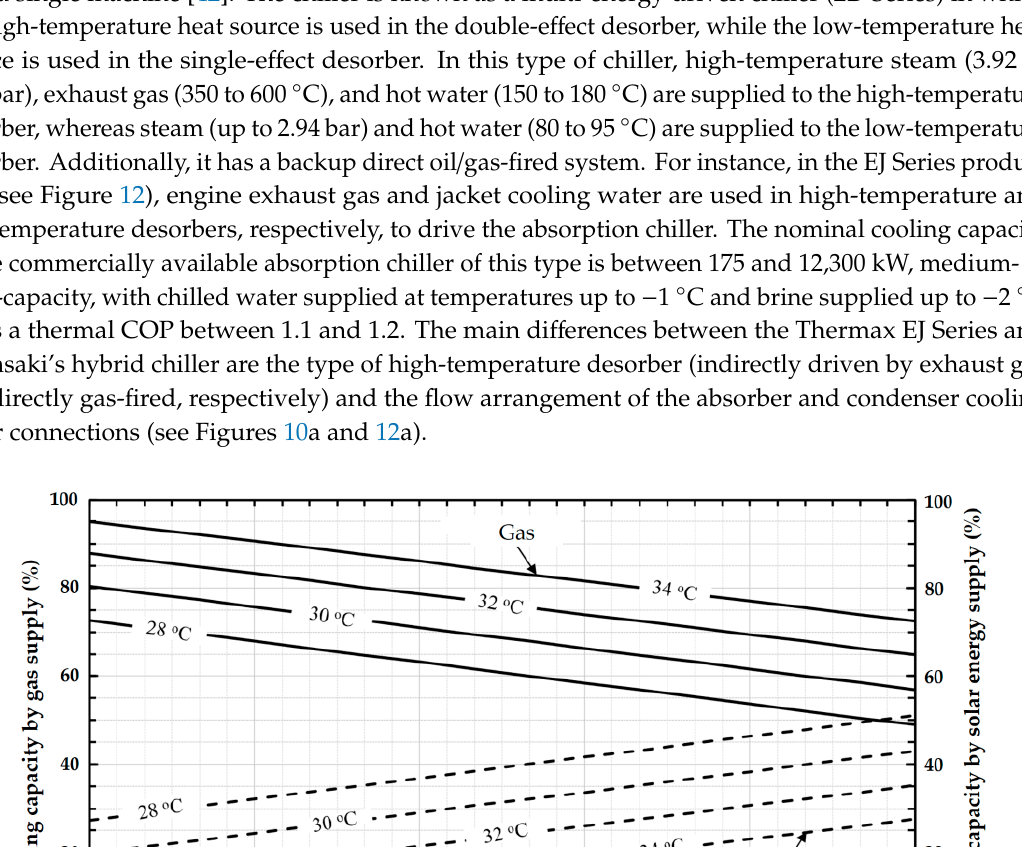
Figure 10. Solar ‐ gas ‐ fired single/double ‐ effect absorption chiller from Kawasaki Thermal Engineering Co. Ltd. Adapted from Reference [41]. (a) Absorption cycle schematic; (b) Absorption chiller external